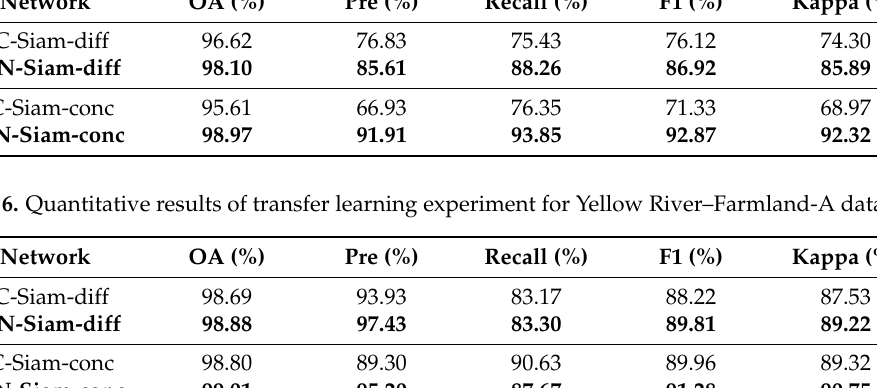
Table 5. Quantitative results of transfer learning experiment for San Francisco dataset. Network